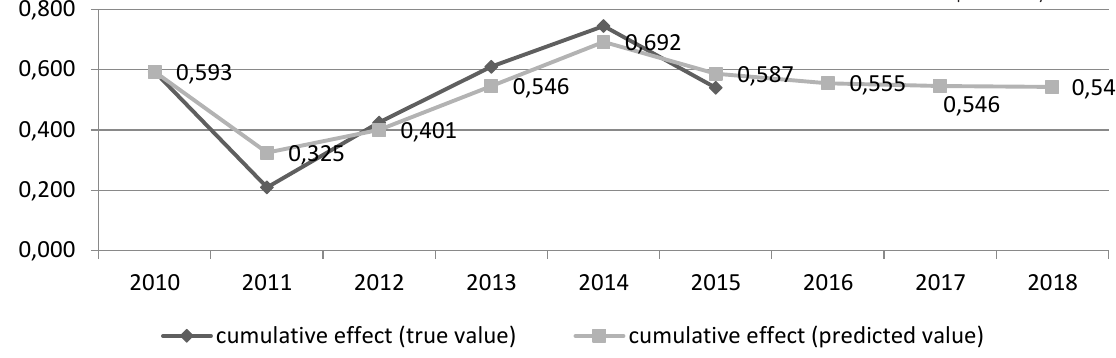
Figure 5. The dynamics of the predicted value for the cumulative effect at PJSC “AutoKrAZ”